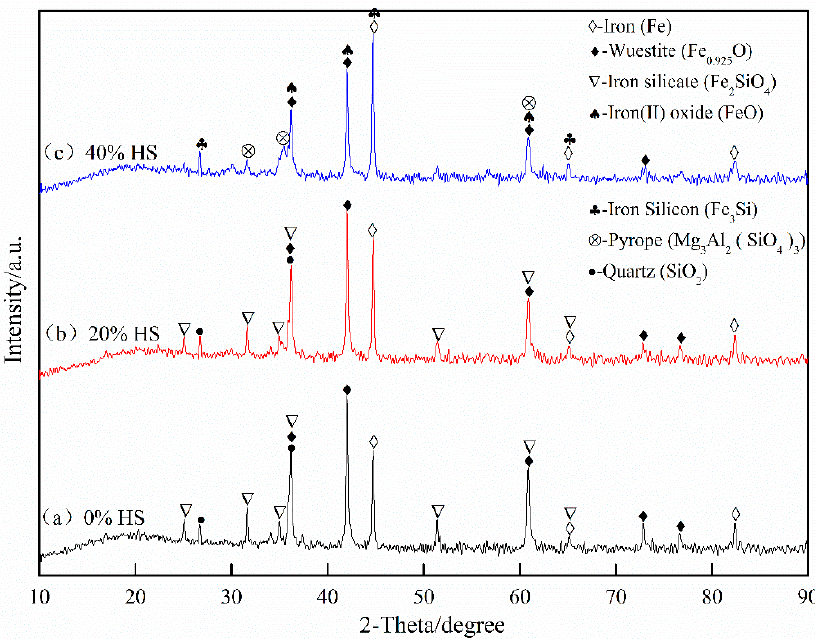
Figure 14. X-ray diffraction analysis of oxidized pellets with sea sand ore reduced at 900 °C for 3 h.